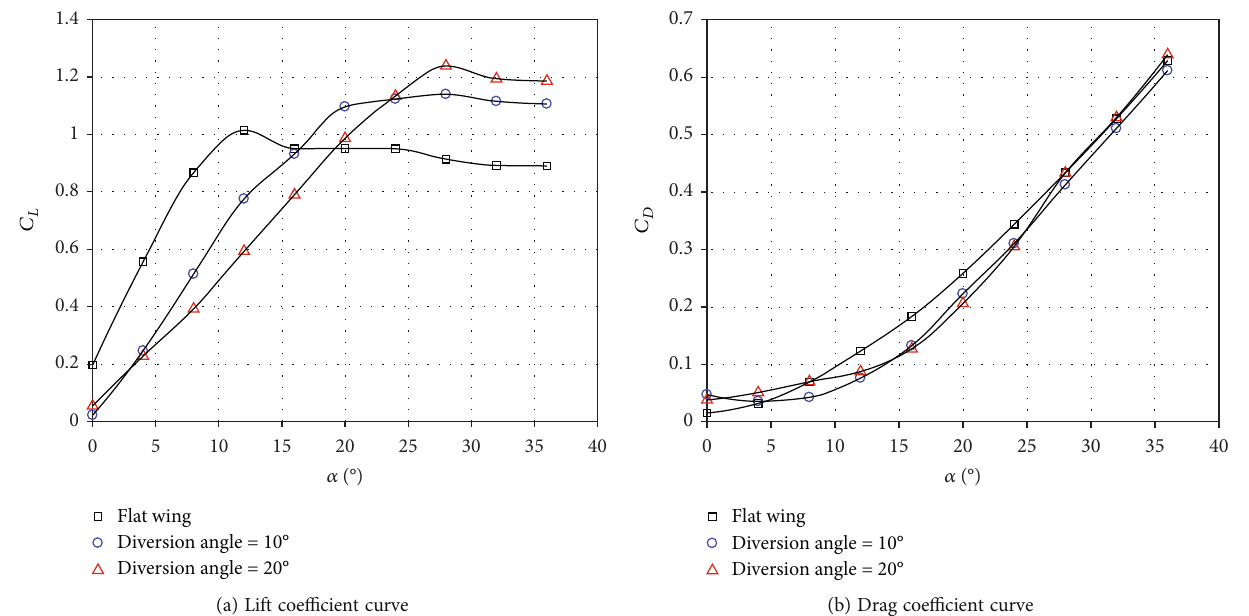
Figure 18: The lift coe ffi cient and drag coe ffi cient curves of the grid fusion lifting surface with di ff erent diversion angles ( Ma = 0 : 6 ).